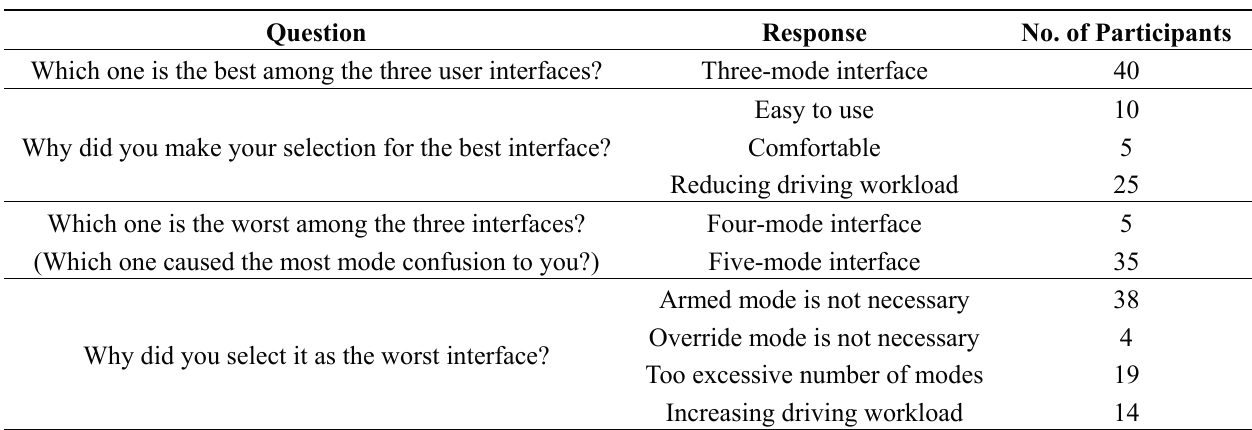
Table 12. Questions and responses after all experiments were